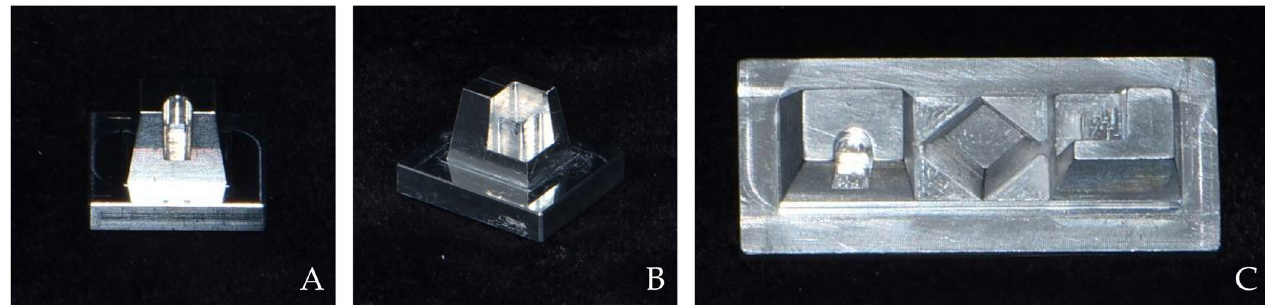
Fig 5. Box plots of the RMS values for three experimental groups (Scancure, IP, VITA) in three reference models. A—inlay model; B—onlay model; C— bridge model.